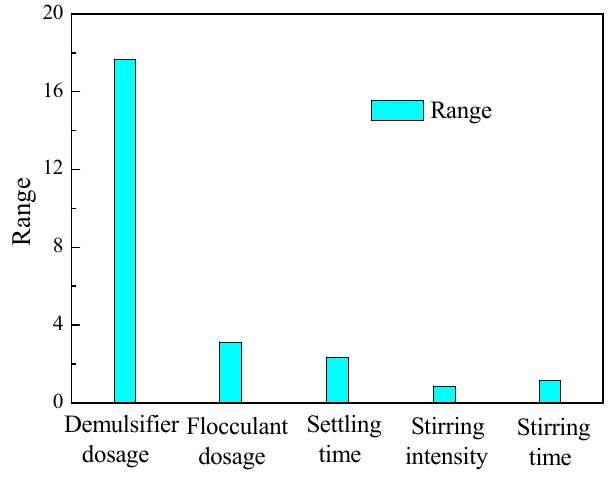
Figure 9. Range values of different factors.